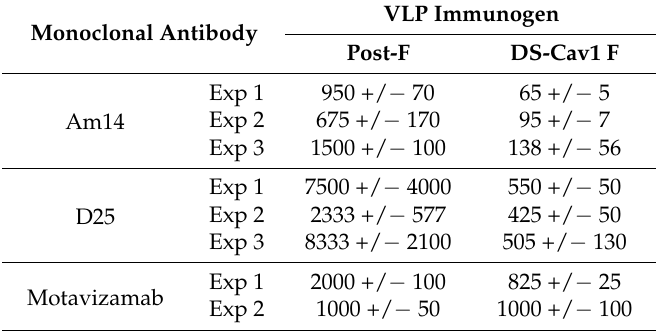
Table 1. Concentration (ng/mL) of Anti-Pre-F IgG Binding Antibodies That Block 50% of Binding of Monoclonal Antibodies to Soluble DS-Cav1 Protein.